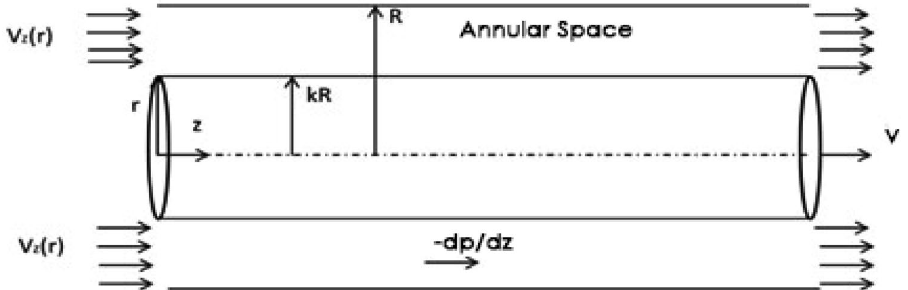
Fig. 1 Flow domain schematic for the parallel flow within concentric annular